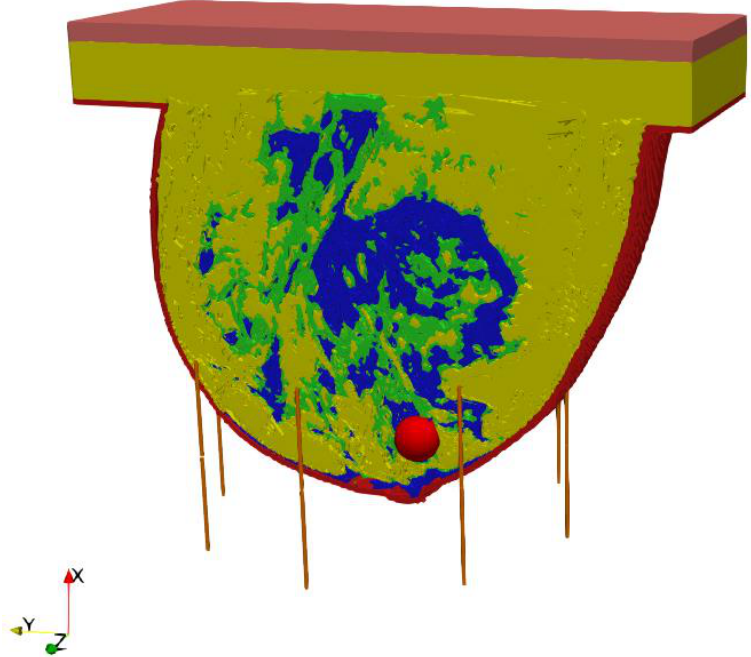
Figure 4. The model of eight element dipole antenna array surrounding the female breast phantom.